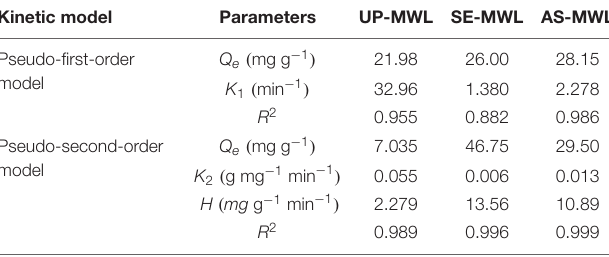
TABLE 2 | Adsorption kinetics model